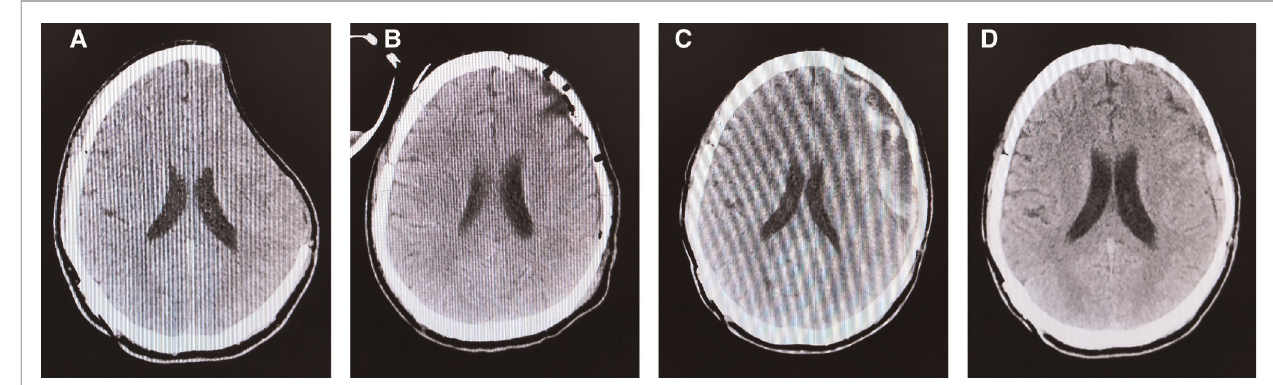
FIGURE 1 | CT scan images before PEEK cranioplasty ( A ), right after the operation ( B ), day fi ve post-operatively ( C ), and day ten post-operatively (